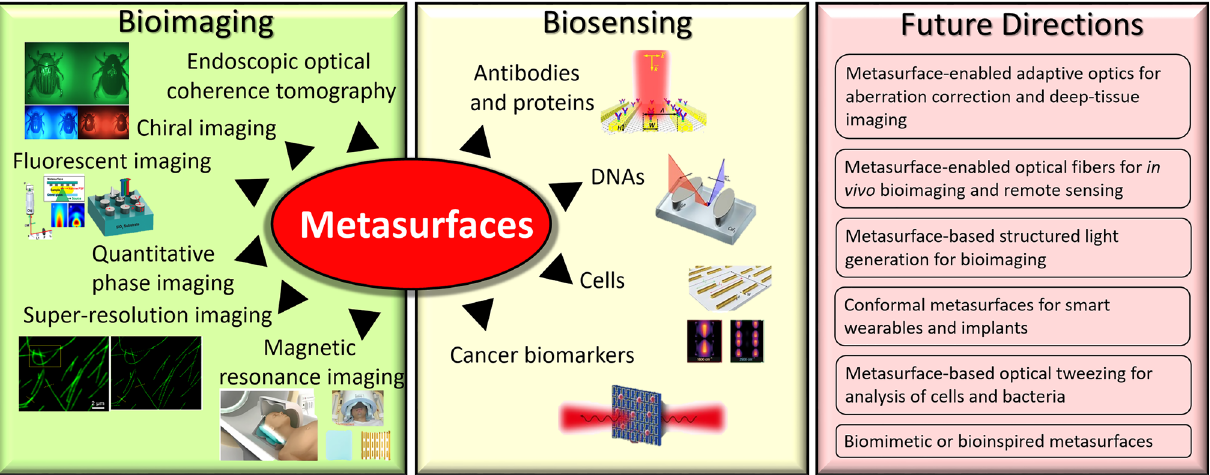
Figure 1: Overview of metasurfaces for bioimaging and biosensing applications and future directions. Chiral imaging: Reproduced with permissionfromKhorasaninejadetal.,NanoLett. 16 ,4595 – 4600(2016)[96]. Copyright2016AmericanChemicalSociety.Directlink:https:// pubs.acs.org/doi/abs/10.1021/acs.nanolett.6b01897. Further permissions related to the material excerpted should be directed to the